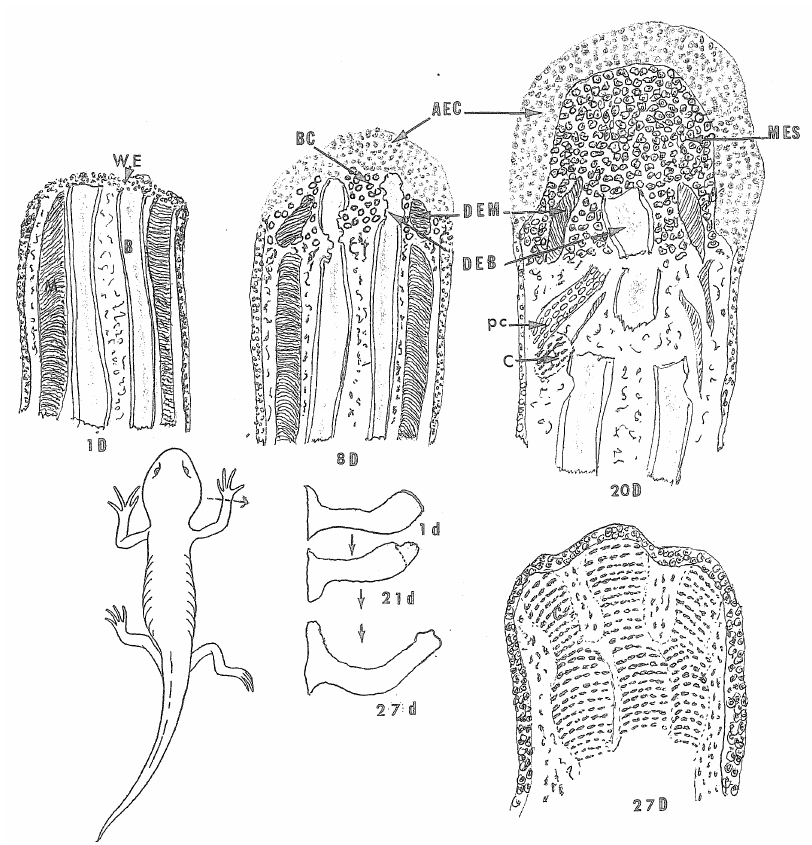
FIGURE 2. Adult newt salamander limb regeneration. 1D: 1 day postamputation with wound epithelium; 8D: 8-day regenerate, early blastema with dedifferentiating bone, cartilage, muscle, and apical epidermal cap; 20D: 20-day regenerate (paddle stage) – a collection of mesenchymal cells (blastema), dedifferentiating tissues, and early differentiation of cartilage; 27D: 27-day regenerate (distal end). Early cartilaginous pattern of three toes. M: muscle; B: bone; C: cartilage; AEC: apical epidermal cap; BC: blastema cells; DEM: dedifferentiating muscle; DEB: dedifferentiating bone; MES: mesenchymal cells (blastema); WE: wound epithelium; ct: connective tissue; pc: